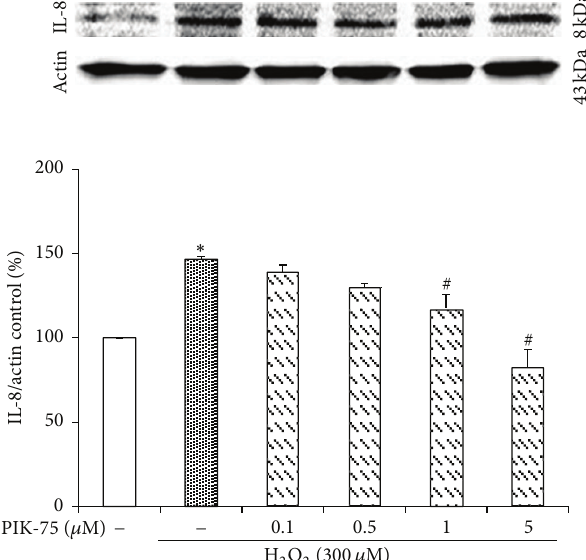
Figure 7: Effect of PIK-75 on IL-8 expression in feline EECs stimulated by H 2 O 2 . Serum-starved EECs were preincubated in the presence of PIK-75. EECs were then stimulated with H 2 O 2 (300 𝜇 M, 6 hours). The expression of IL-8 was estimated by Western blot analysis. Data are expressed as means ± S.E of four experiments (Student’s t -test; ∗ 𝑃 < 0.05 versus control, # 𝑃 < 0.05 versus H 2 O 2 alone).